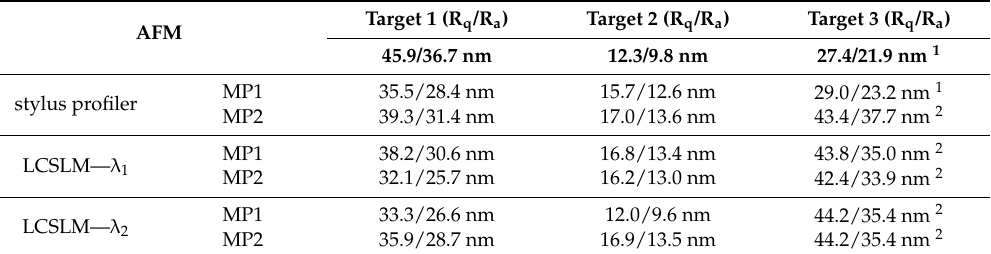
Table 2. Experimental results of R q,r and R a,r for three targets measured by atomic force microscopy (AFM), stylus profiling, and the LCSLM with λ 1 = 457.9nm and λ 2 = 501.7nm.